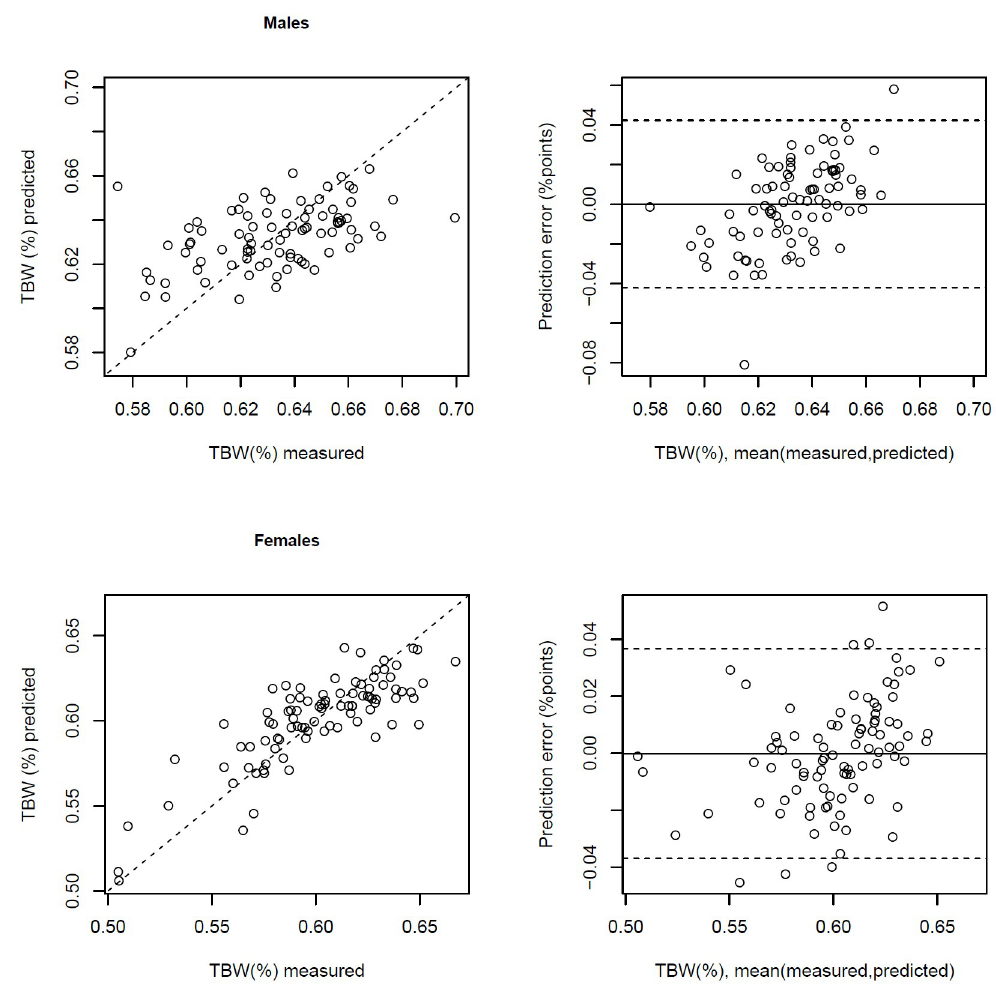
Fig 3. Correlation between total body water (TBW) in % measured by deuterium dilution with TBW (%) predicted by bioimpedance using the predictive equation in Table 4 (r 2 = 0.26 for males, 0.68 for females), and Bland-Altman plots showing the difference in TBW (%) measured by deuterium dilution and predicted by the bioimpedance equation against their